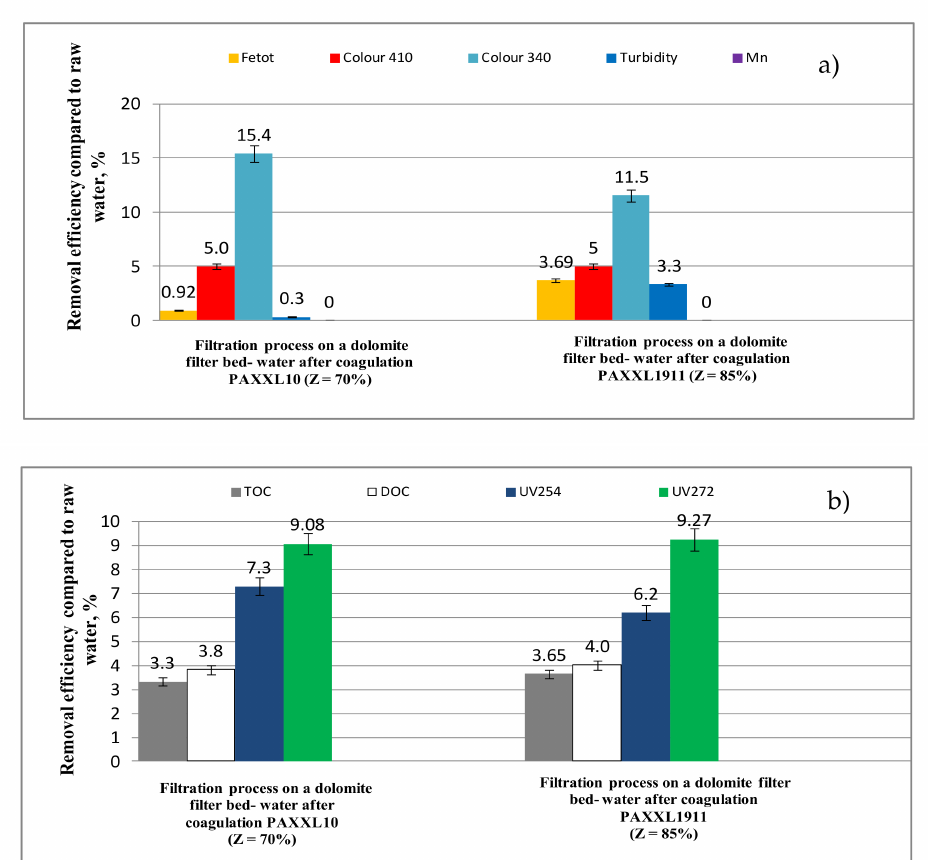
Figure 8. Efficiency of iron total, colour at wavelength 410 nm and 340 nm, turbidity, manganese ( a ) and TOC, DOC, UV 254 , UV 272 ( b ) removal from water by filtration with a dolomite